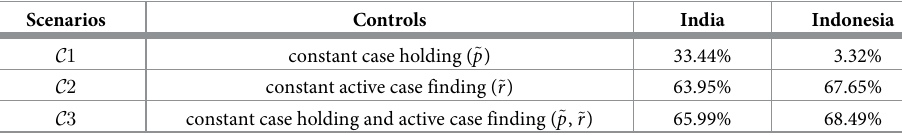
Table 2. Percentage reduction in the TB incidence